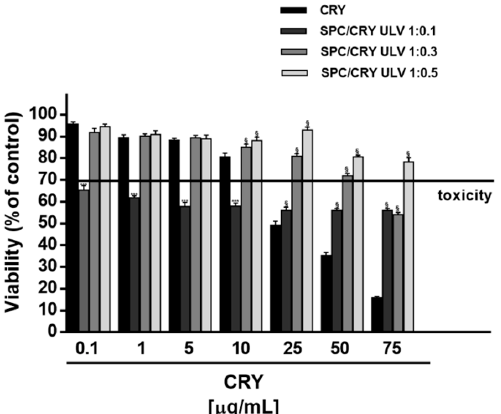
Figure 4. Cytotoxicity of SPC ULV differently loaded with CRY (1:0.1, 1:0.3 and 1:0.5 mol/mol) in HepG2 cells after 24 h incubation. *** p < 0.001 vs CRY; denotes a statistically significant increase of cytotoxicity respect to pure CRY (ANOVA + multiple Dunnett’s comparison post-test). § p < 0.001 vs. CRY, denotes a statistically significant reduction respect to CRY cytotoxicity (ANOVA + multiple Dunnett’s comparison post-test). A cell viability lower than 70% respect to control (i.e., vehicle-treated cells) was considered as cytotoxic [26].